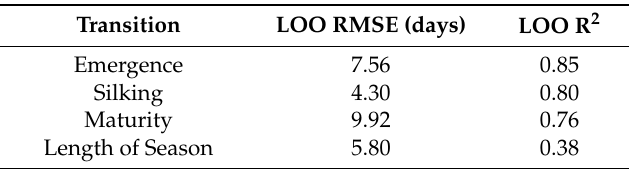
Figure 7. Scatterplot of actual yields versus LOO APSIM-predicted yields for clusters with LOO R 2 values above 0.40 (using clustering in Figures 5 and 6). Colorbar represents number of points at a particular pixel in the scatterplot. Table 4. State-level performance of the 20-weather-cluster-based calibration in predicting phenological stage transition dates as compared to ground-truth USDA NASS crop progress report data for clusters with LOO R 2 values above 0.40